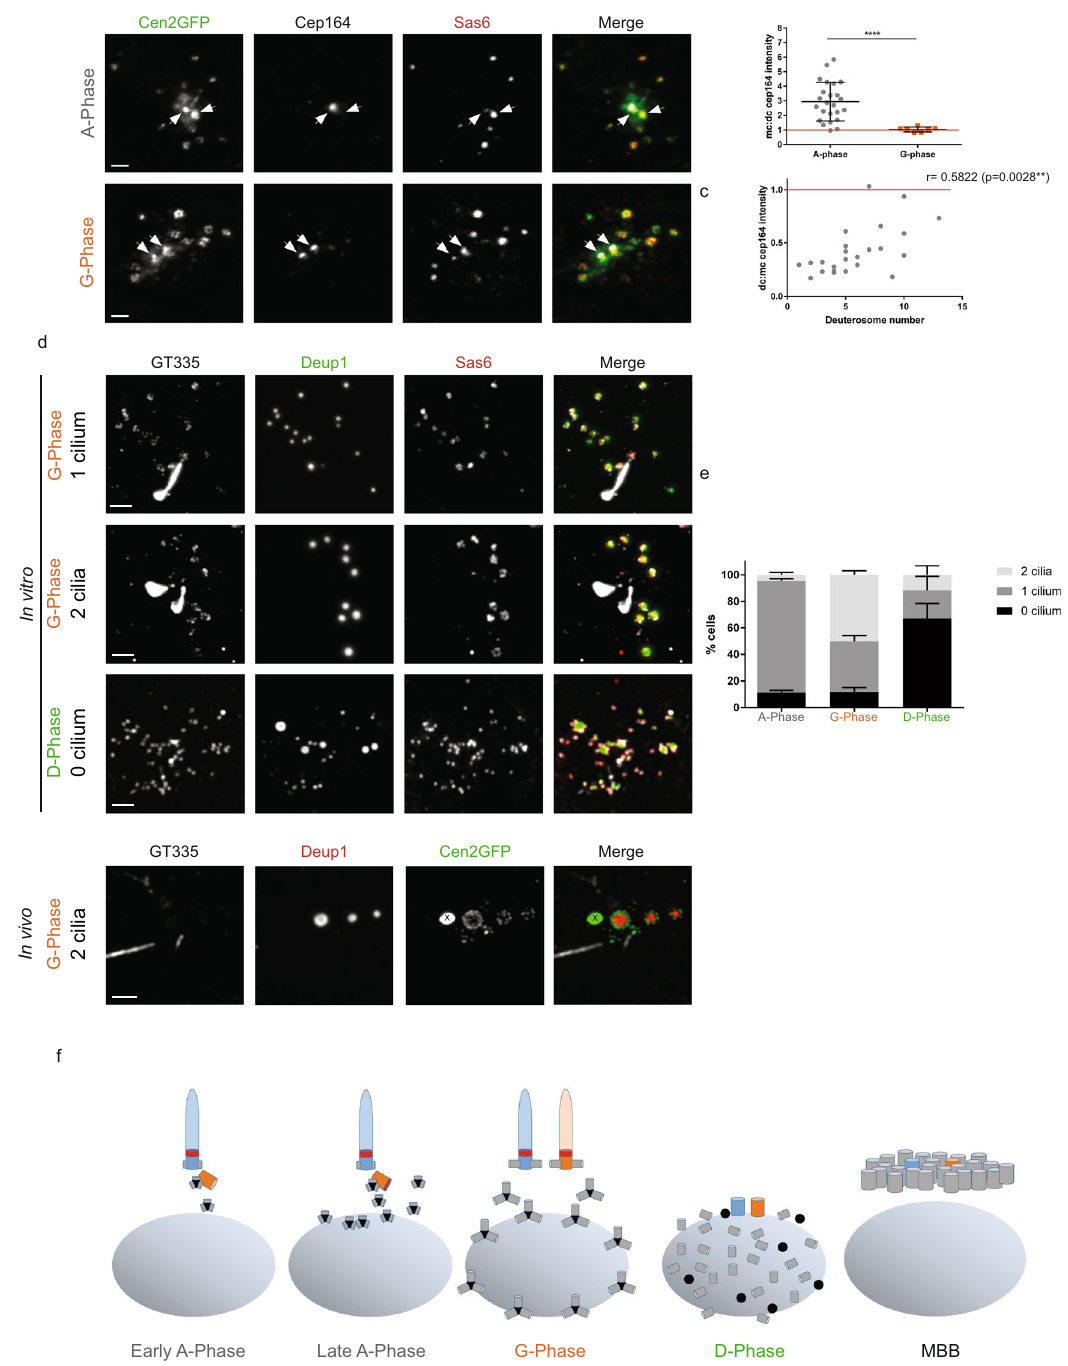
Figure 2. Daughter-to-mother centriole conversion at the A- to G-phase transition. ( a ) Cep164 and Sas6 immunostainings on Cen2GFP ependymal progenitors during A- and G-Phases. Arrows indicate centrosomal centrioles. ( b ) Mother:daughter centriole (mc:dc) Cep164 signal ratios in A-phase (n = 24 cells) and G-Phase (n = 7 cells). ( c ) Correlation between mc:dc Cep164 signal ratios and deuterosome numbers in the cells during A-Phase (n = 24 cells from b ). ( d ) GT335, Deup1 and Sas6 immunostainings on ependymal progenitors during G- and D-Phases in vitro and G-phase in vivo . ( e ) Percentage of cells with 0, 1 or 2 GT335 positive cilia in A-, G- and D-phases in vitro (n = 210, 73 and 21 cells in A-, G- and D-phase, respectively). ( f ) Representative scheme of centrosomal centriole behaviour during centriole amplification. Nucleus is represented in gray, deuterosomes in black, procentrioles in gray, Cep164 in red, mother centriole in blue, daughter centriole in orange. « X » indicates Cen2GFP aggregate. Scale bars: 2 µ